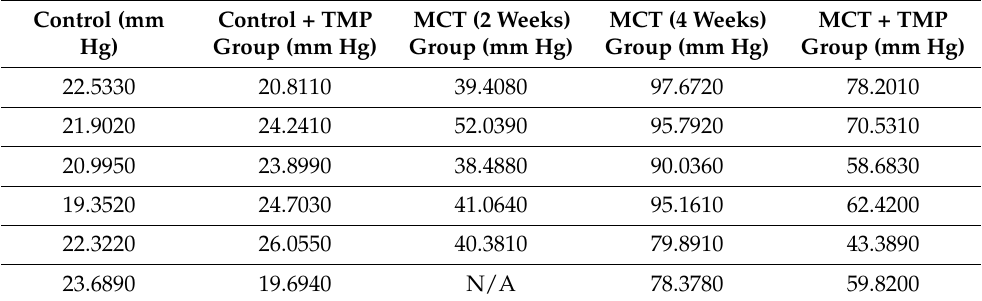
Figure 13. Representative in vivo right ventricle systolic pressure (RVSP) measurements of: ( A ). Groups 1 & 2; ( B ) Groups 3 & 5; and ( C ) pressure measurement comparison between different rat groups from insufflator (dry powder aerosol) study. Table 5. In vivo right ventricle pressure hemodynamic measurements from insufflator (powder aerosol)